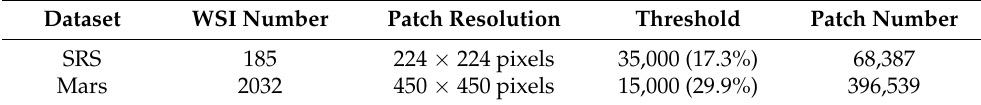
Table 1. Some indicators in data processing.